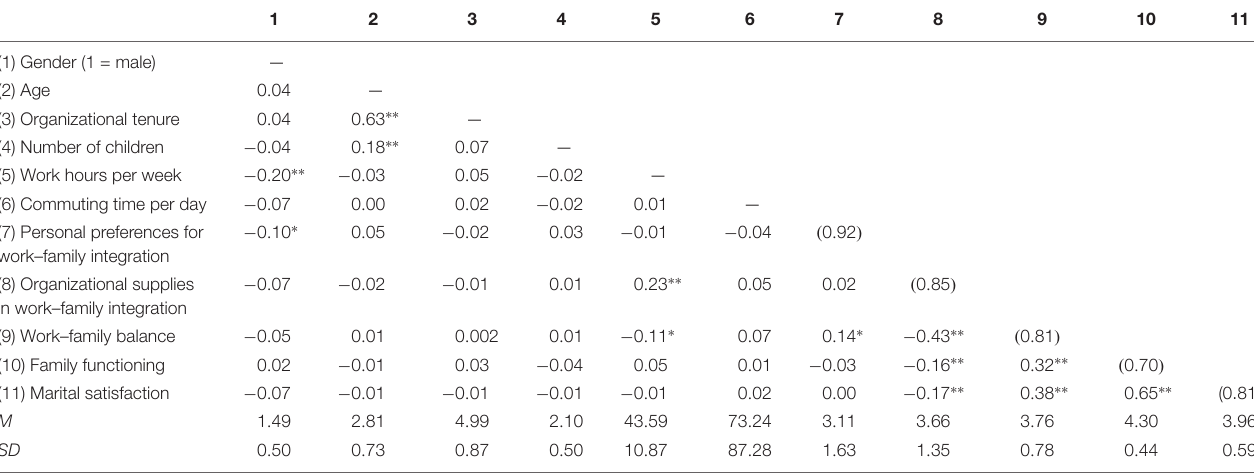
TABLE 1 | Mean, deviations, and correlations for all variables.